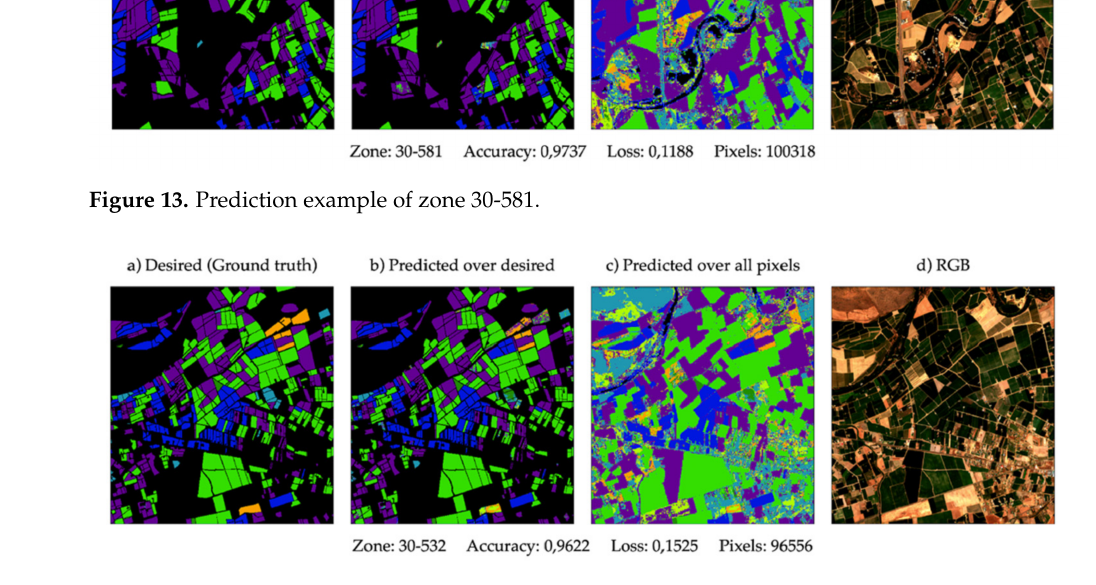
Figure 14. Prediction example of zone 30-532.